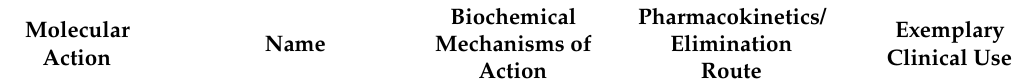
Table 2. Currently used anti-fibrinolytic